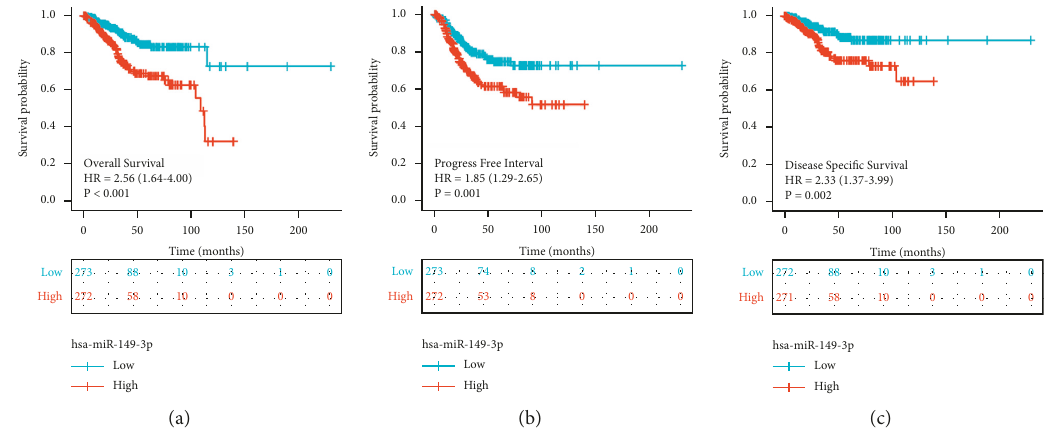
Figure 3: The relationship between the expression level of miR-149-3p and prognosis. (a) OS, overall survival; (b) PFI, progress-free interval; (c) DSS, disease survival specific. Table 3: Univariate and multivariate Cox regression analysis of OS and clinical features in UCEC patients.